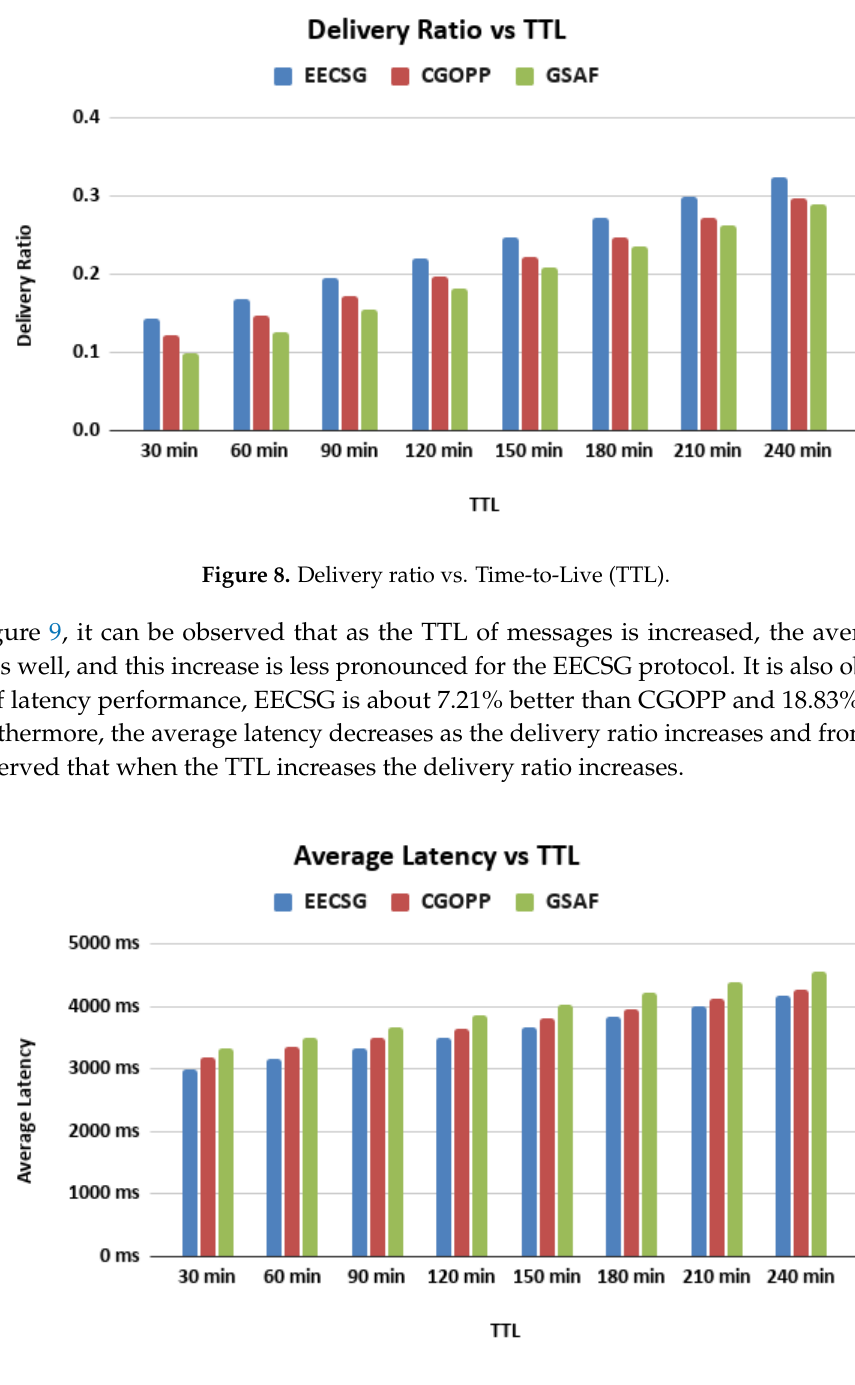
Figure 9. Average latency vs.